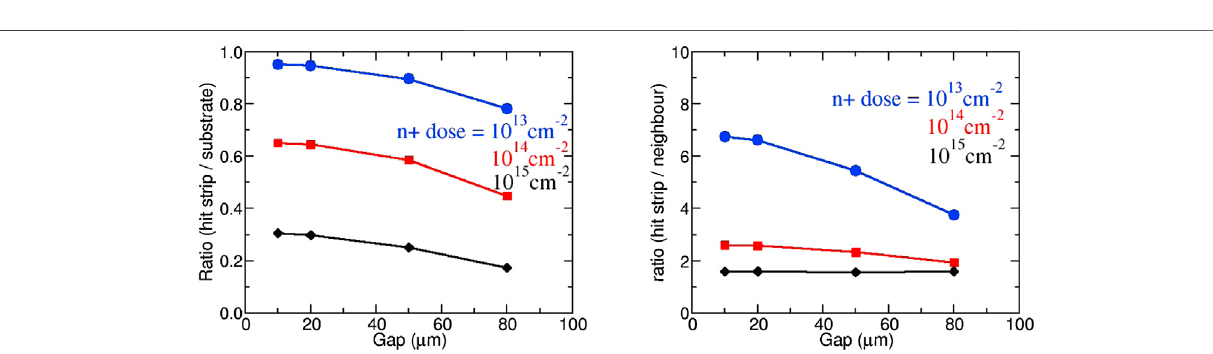
Frontiers in Physics |